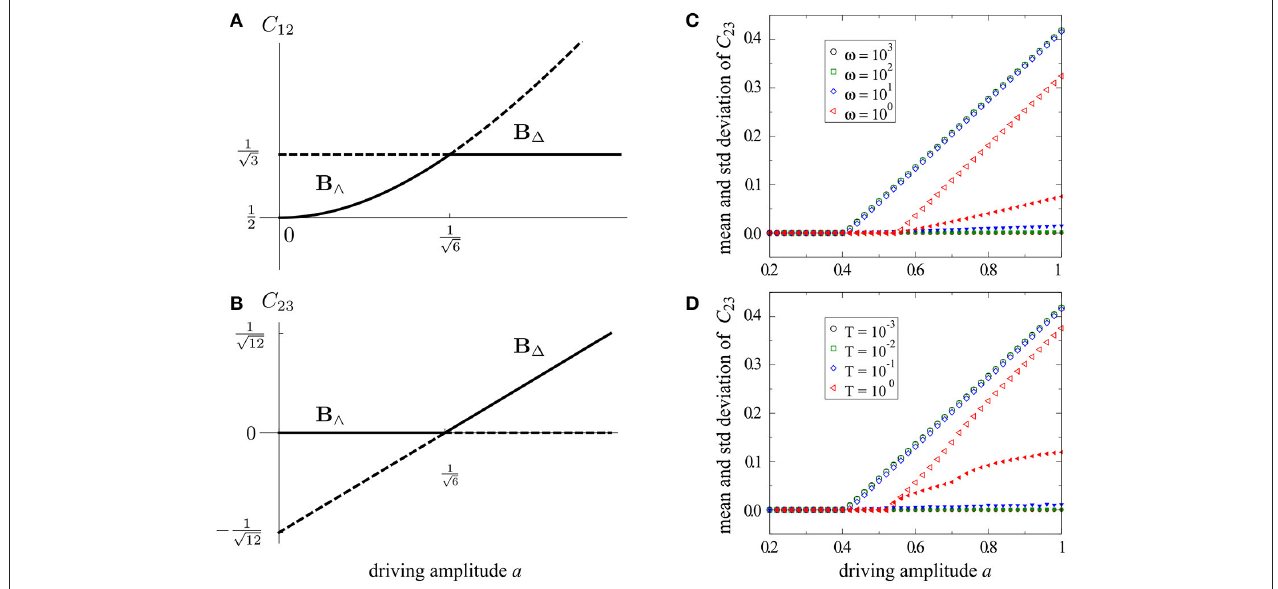
FIGURE 2 | Bifurcation diagrams for the 3-node model ( Figure 1B ). Analytical solutions for periodic driving are shown in (A,B) , including stable (solid) and unstable (dashed) branches. Simulated behavior for the shunting conductance C 23 is shown for periodic driving (C) and rapid stochastic driving (D) . Mean values (large open symbols) and standard deviation (small filled symbols) are measured for C 23 ( t ) over the entire simulation. For both periodic and stochastic driving the predicted bifurcation point a c 1 / √ 6 is asymptotically reached as the characteristic driving frequency T − 1 → → ∞